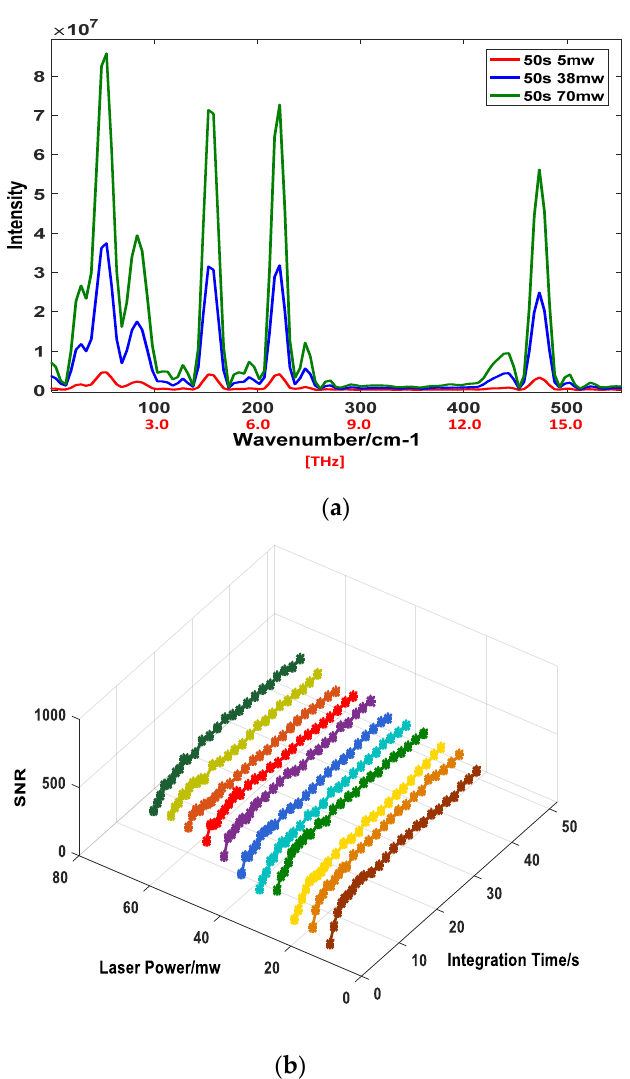
Figure 4. ( a ) THz Raman spectra of sulfur at the same integration time and different powers. ( b ) SNR of sulfur under different laser powers and integration times.